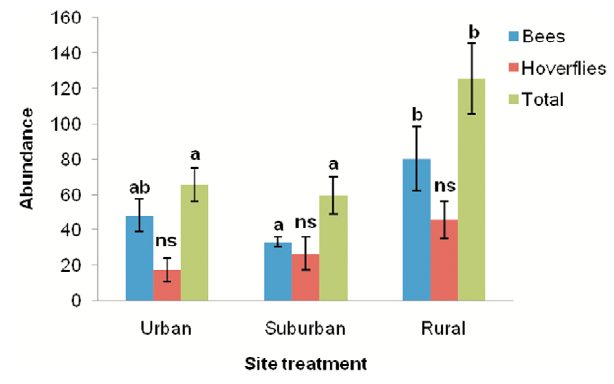
Figure 1. Relationships between site treatment and total abundance of bees, hoverflies and total pollinators. Error bars = + / 2 1SE. Bars that do not share a letter showed significant differences ( P , 0.05) between treatments. Ns = no significant